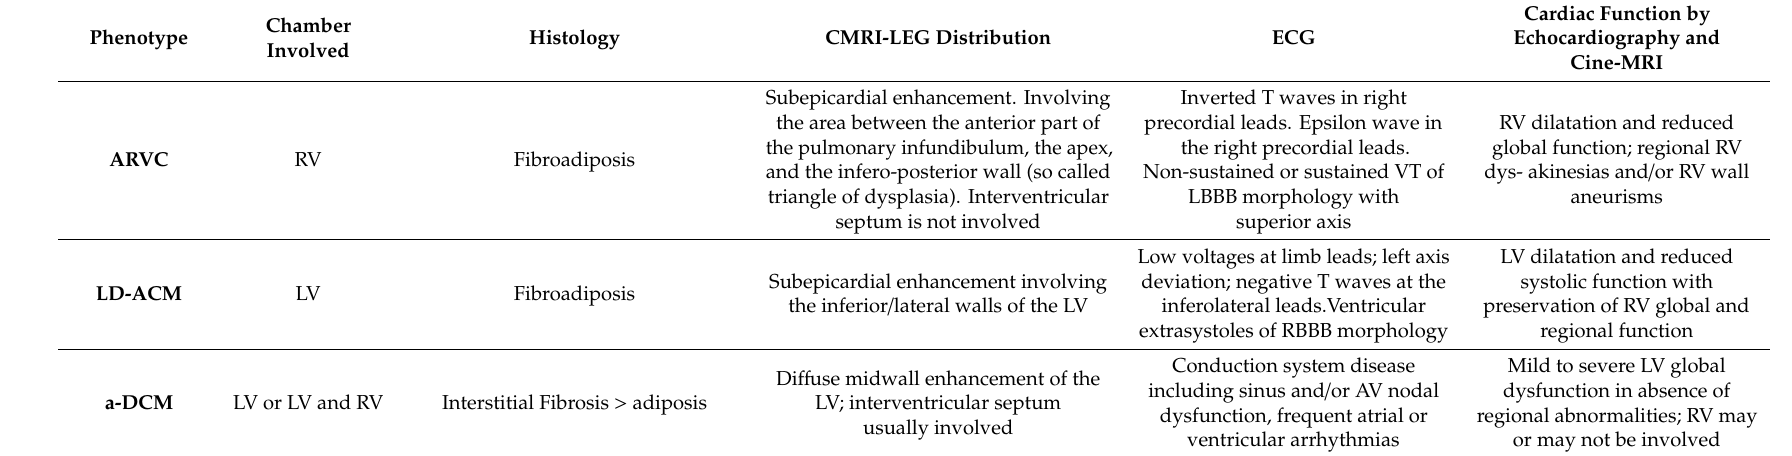
Table 2. Distinctive imaging and electrocardiographic features of ARVC, LD-ACM and